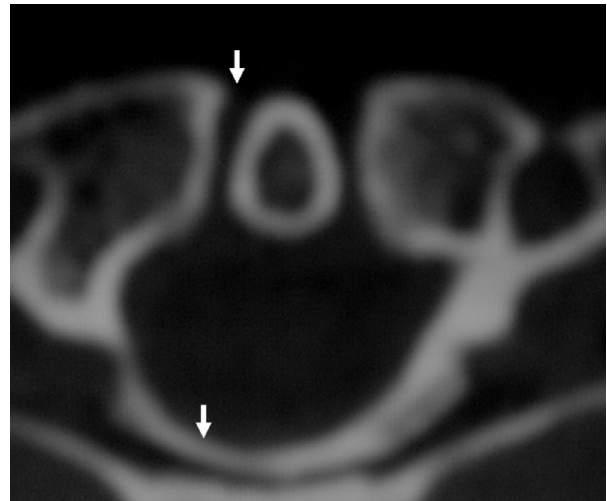
Figure 2 - Anteroposterior skull radiograph showed excessive aeration of the frontal sinuses, osteopenia and total loss of teeth because of dentino- genesis imperfecta.